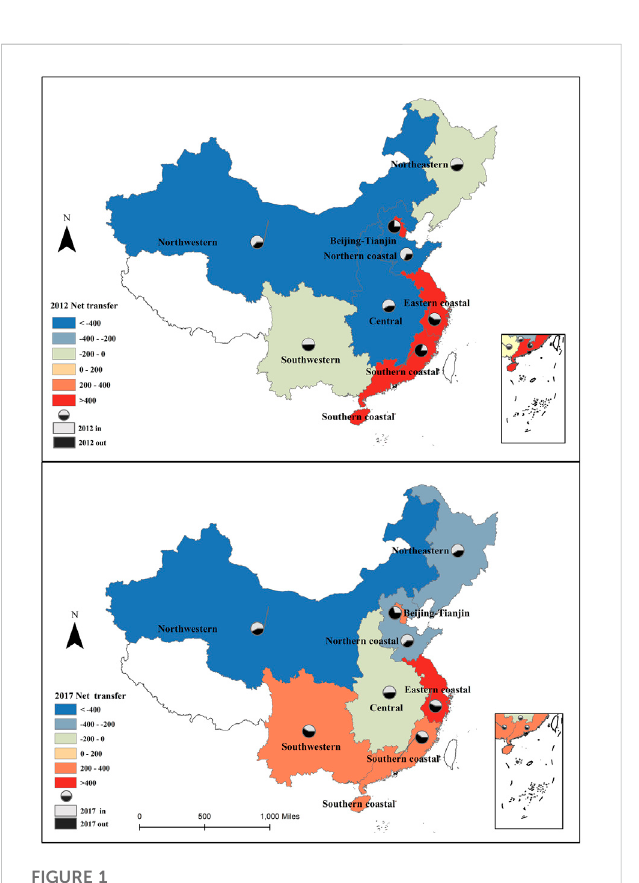
FIGURE 1 Embodiedcarbonnettransferininter-provincialtradefrom2012to 2017.